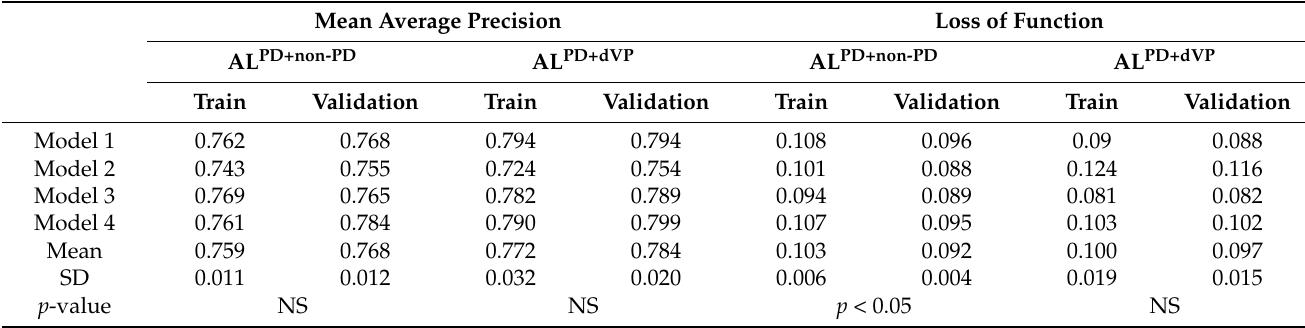
Table 1. Mean average precision and loss function during the training session using the faster region-based convolutional neural network with 4-fold